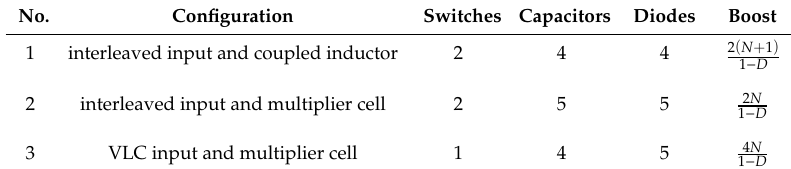
Table 1. Comparison of the recently discovered high boost ratio configurations.